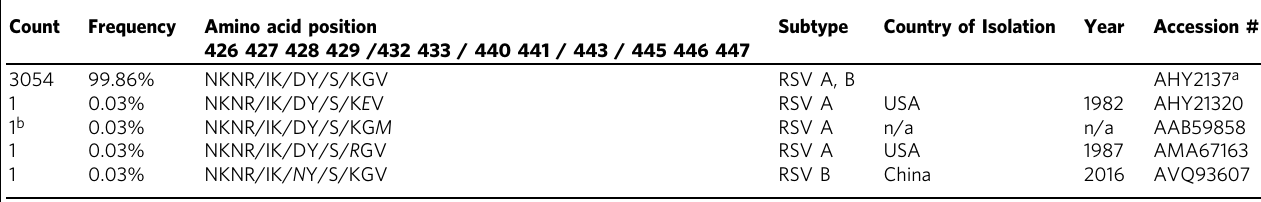
Table 3 Conservation of RSV F protein amino acids in the RB1 binding